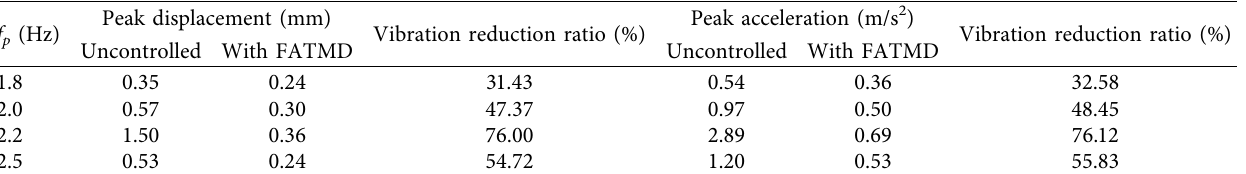
Figure 14: The acceleration envelope diagram of the bridge ( f Table 3: Dynamic responses in the midspan of the bridge with and without the FATMD.